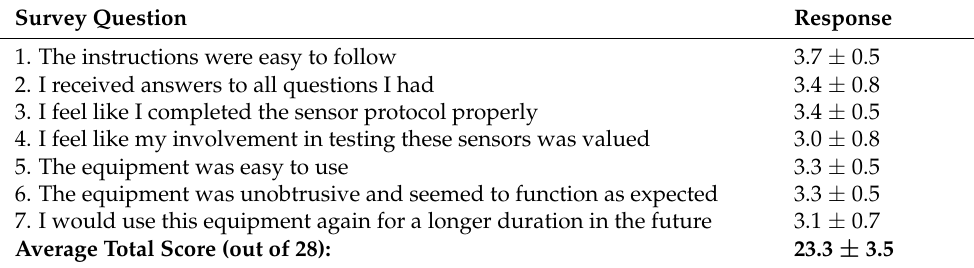
Table 1. User satisfaction and acceptability survey